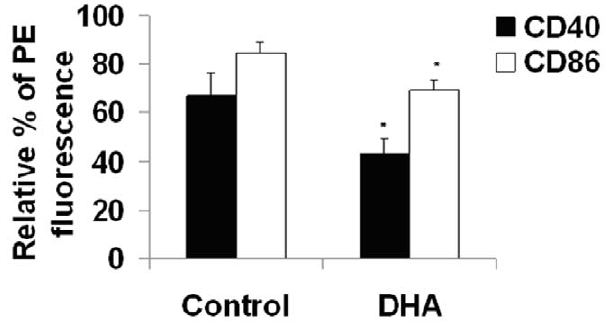
Figure 2. DHA reduces expression of CD40 and CD86 in infected J774A.1 cells primed with IFN c . Macrophages were incubated with 50uM DHA for 24 hours and infected with M. tuberculosis for 1 h. Then cells were incubated with PE-conjugated antibodies to CD40 and CD86 and intensity of fluorescence was quantified by flow cytometry, as described in the Materials and Methods . Cells were seeded at a density of 500,000 cells/well. a. Quantitative data represent the relative percentage of PE fluorescence (mean 6 SEM; n=9) for CD40 and CD86. * Indicates a significant effect of DHA compared to Control, * p , 0.05. b. Comparative histograms of CD40 and CD86 expression in fatty acid-treated cells in DHA-treated cells after 24 h, compared to other fatty acid treatments. Data are representative of three independent experiments. Abbreviations used: DHA, docosahexaenoic